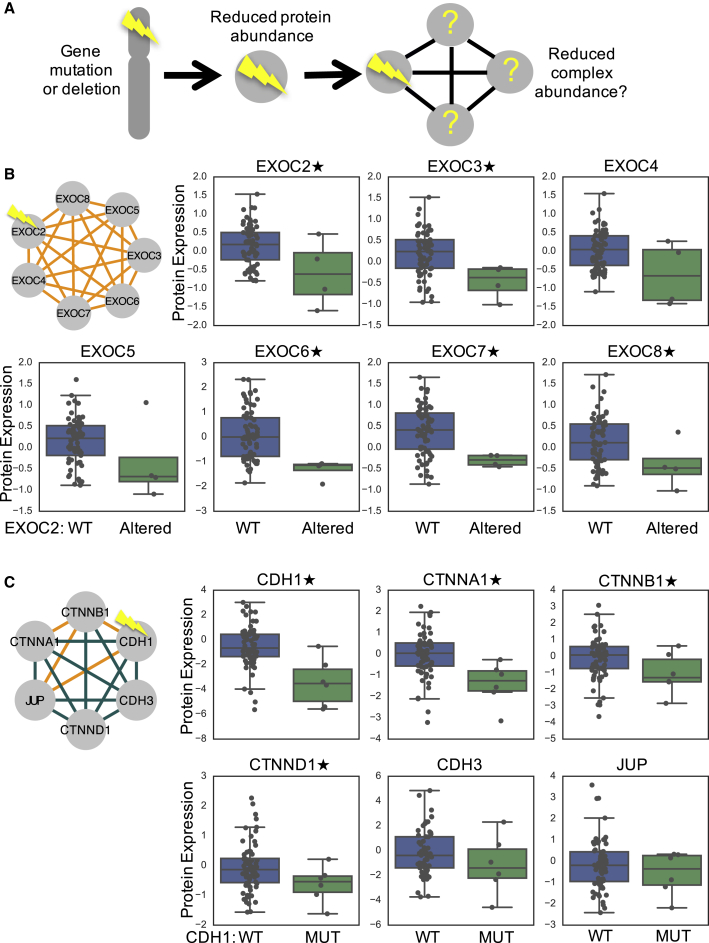
Subunit Loss Is Associated with a Reduction in Protein Complex Expression(A) Model displaying a potential series of events; mutation or deletion of one subunit is associated with reduced protein abundance of that subunit and potentially a reduction in expression of the entire complex.(B) Mutation or deletion of EXOC2 is associated with a reduction in protein abundance of the exocyst complex (BrCa-Core 27). Boxplots display the protein abundance of different subunits partitioned according to EXOC2 status. Each boxplot shows the median and interquartile range. Genes marked with a star indicate those whose proteomic abundance is significantly lower (one-sided Mann-Whitney test, p < 0.05) in samples with EXOC2 mutation/deletion.(C) CDH1 mutation is associated with a reduction in protein expression of an adherens junction complex (BrCa-Core 30). Legend as for (B).